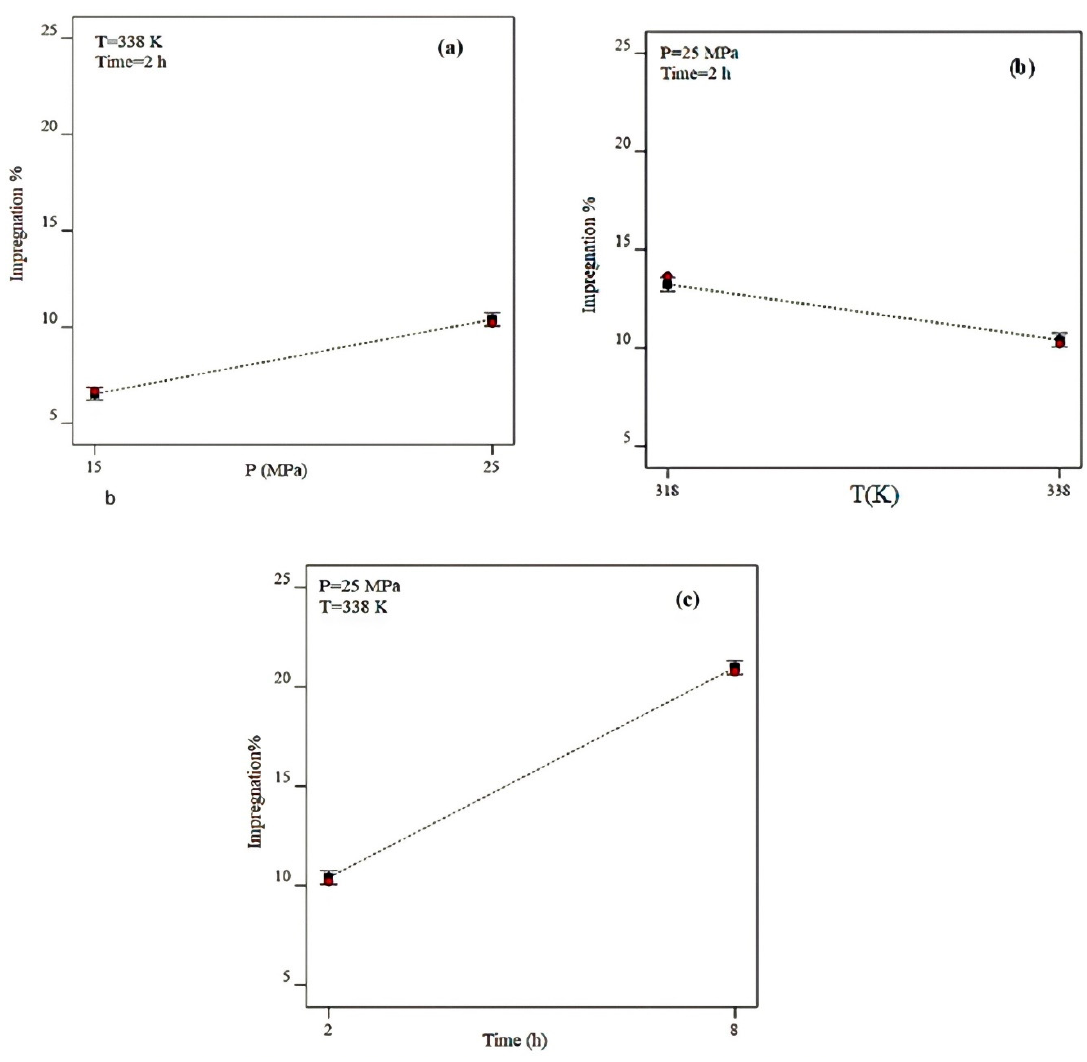
Figure 5. One factor plot to represent the effect of ( a ) pressure at a constant temperature of 338 K and impregnation time of 2 h ( b ) temperature at a constant pressure of 25 MPa and time of 2 h, and ( c ) time at a constant temperature of 338 K and pressure of 25 MPa, on the loading of EO in PLA films.